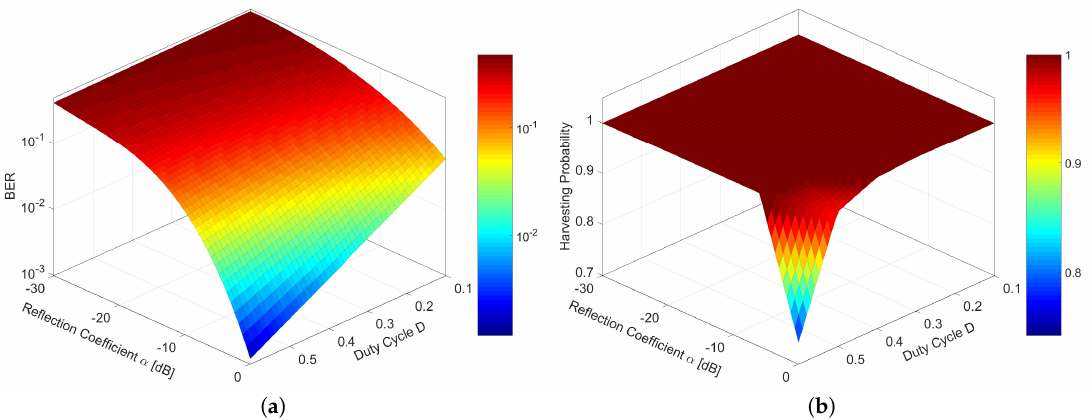
Figure 11. Effect of the duty cycle D and the reflection coefficient α for detection and energy harvesting performances ( D = 0.1 represents the TD-AmBC system). ( a ) BER performance in MSC-AmBC ( K = 10, ζ = 0.16, M = 2). ( b ) Harvesting probability in MSC-AmBC ( K = 10, ζ = 0.16, M = 2).